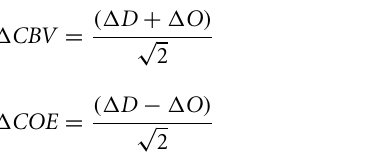
images with a 3 Tesla MRI (Philips Co., Achieva 3.0 Quasar